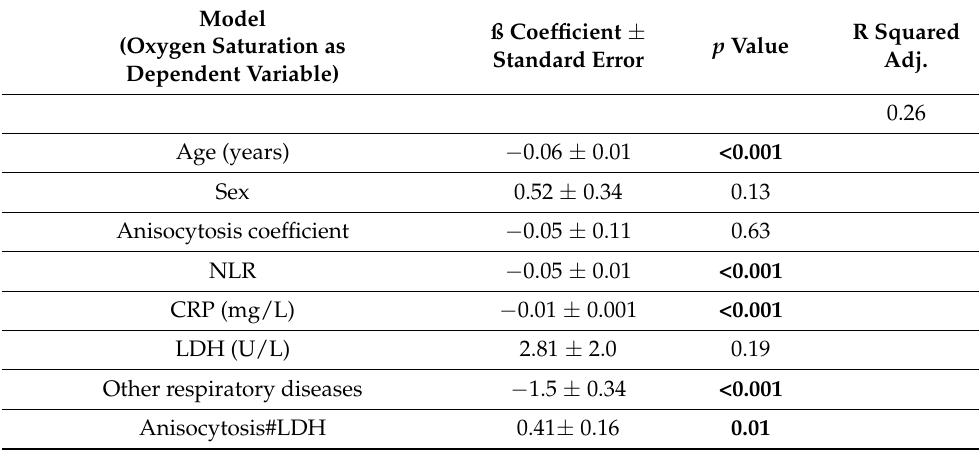
Table 5. Linear regression model involving inflammatory and oxidative stress markers as predictors of oxygen saturation in COVID-19 infected